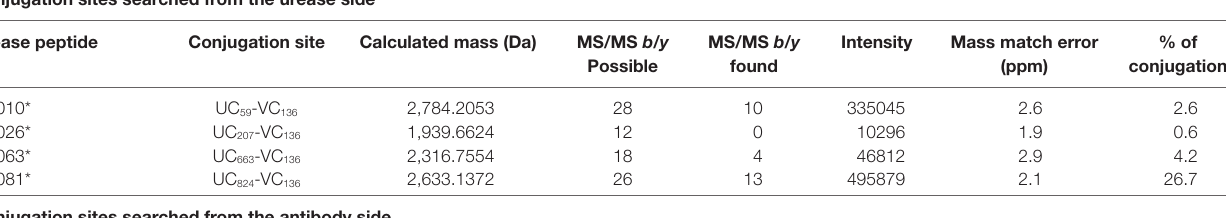
conjugation sites searched from the antibody side V21h4 c-term peptide